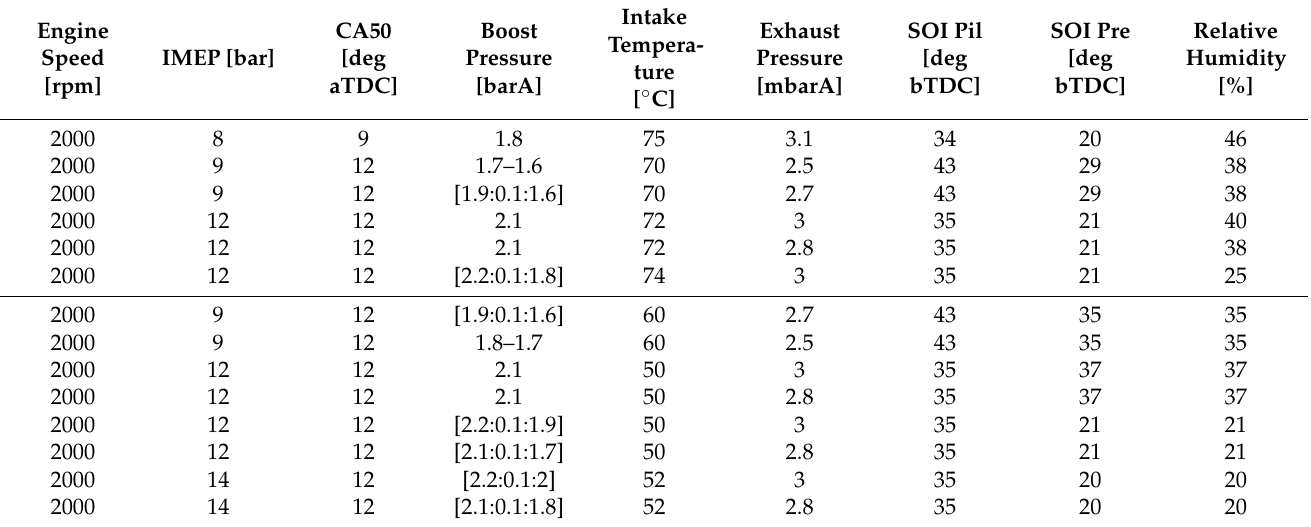
Table 9. Engine operating conditions for ID model calibration running switching pattern methodology.